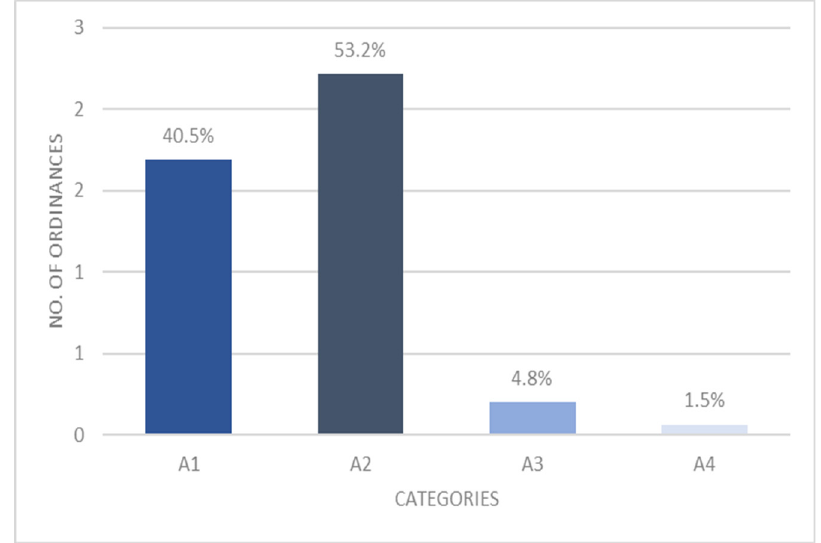
Figure 2. Number of ordinances and their relative frequencies within the categories of